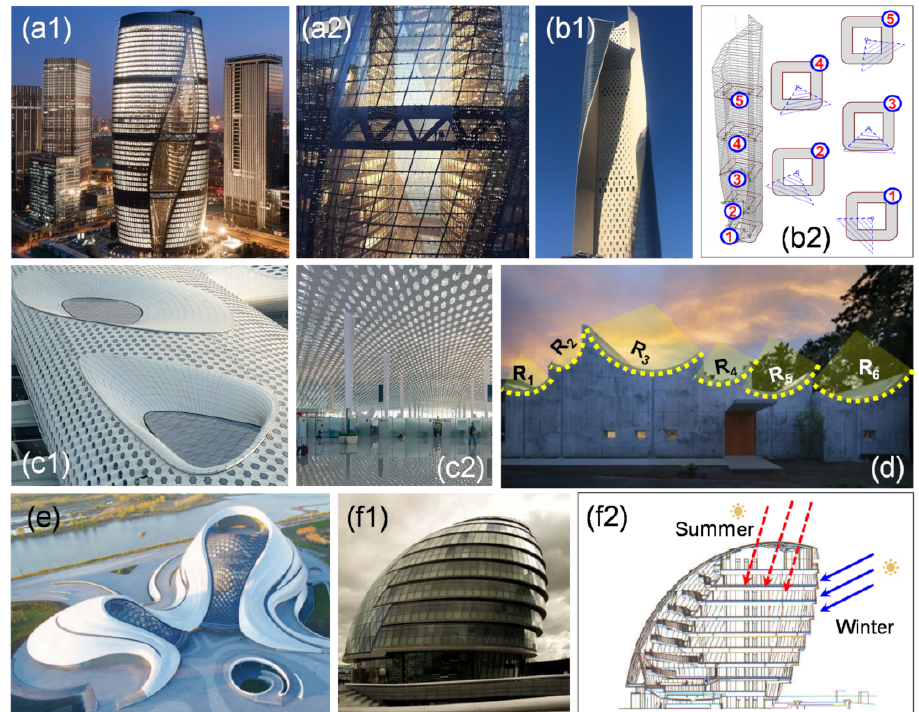
Figure 4. ( a ) Beijing Lize SOHO [88]: ( a1 ) overall appearance and ( a2 ) atrium. ( b ) Al Hamra Tower: ( b1 ) overall appearance [89] and ( b2 ) reverse design [90]. ( c ) Shenzhen Bao’an International Airport Terminal 3 [91]: ( c1 ) lighting design and ( c2 ) interior setting. ( d ) Shonan Christ Church [92]. ( e ) Harbin Grand Theater [93]. ( f ) London City Hall: ( f1 ) overall appearance [94] and ( f2 ) setback terrace design scheme